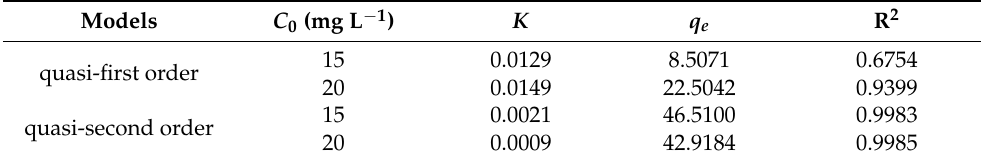
Figure 6. An ( a ) quasi- fi rst-order model, ( b ) quasi-second-order model, and ( c ) intra-particle di ff u- Figure 6. ( a ) quasi-first-order model, ( b ) quasi-second-order model, and ( c ) intra-particle diffusion sion model for de fl uoridation of Ce-H3TATAB-MOFs. model for defluoridation of Ce-H3TATAB-MOFs. Table 1. Fi tt ed parameters of the quasi- fi rst order and quasi-second order models. Table 1. Fitted parameters of the quasi-first order and quasi-second order models.